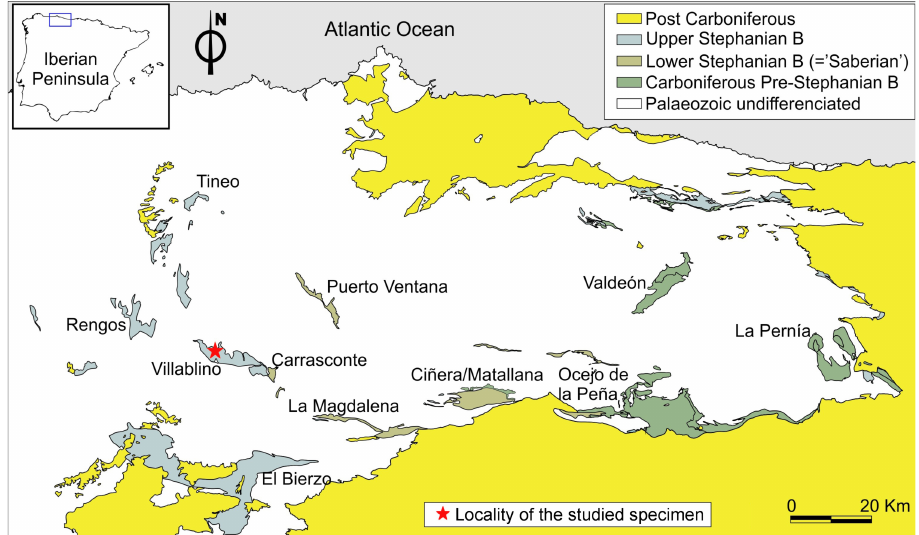
Figure 1. Distribution of continental and transition deposits corresponding to upper Moscovian (Asturian) to lower Permian interval of NW of the Iberian Peninsula of the new specimen. Modified from Santos et al.